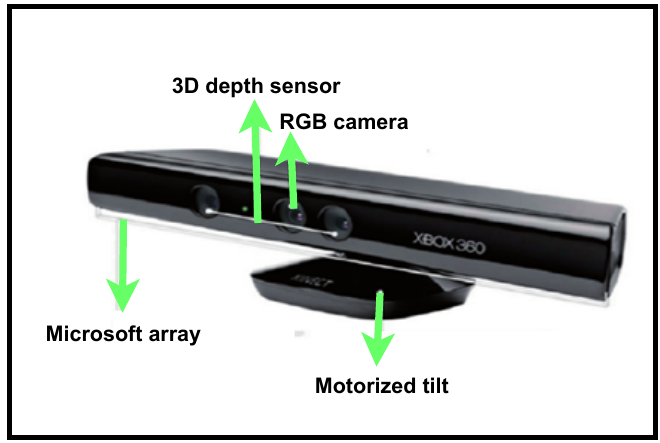
Figure 2. Microsoft Kinect